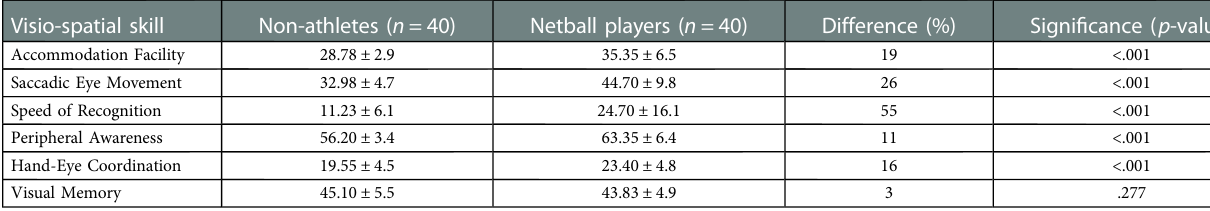
TABLE 2 Visio-motor expertise comparison in netball players and non-athletes. Visio-spatial